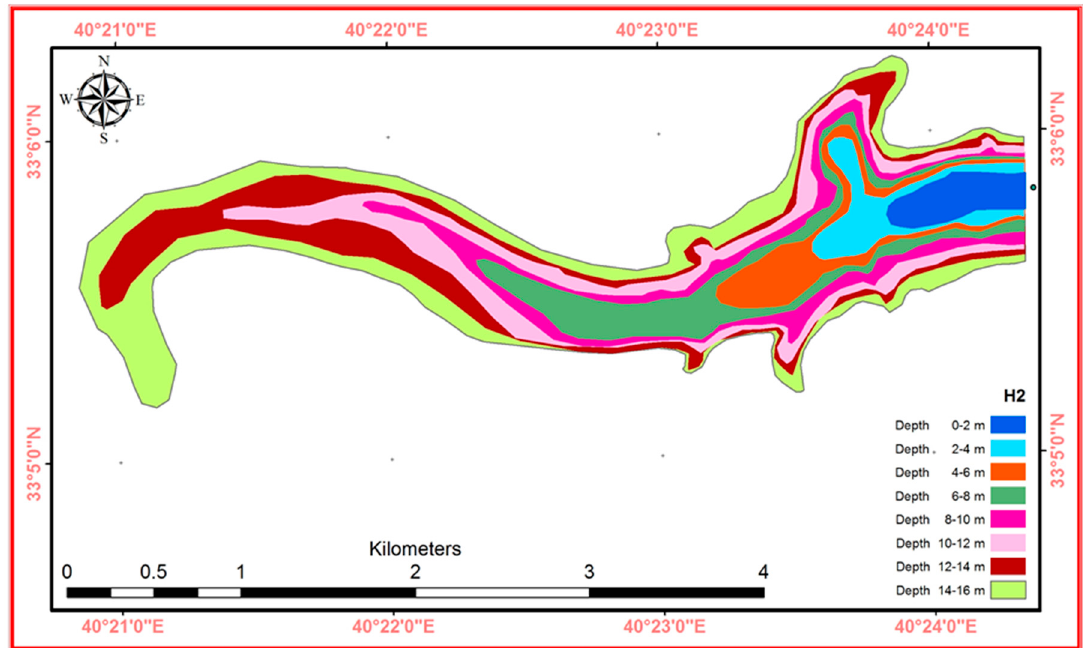
Figure 3. Area–volume curve, area, and volume thematic map calculated for every two meters.